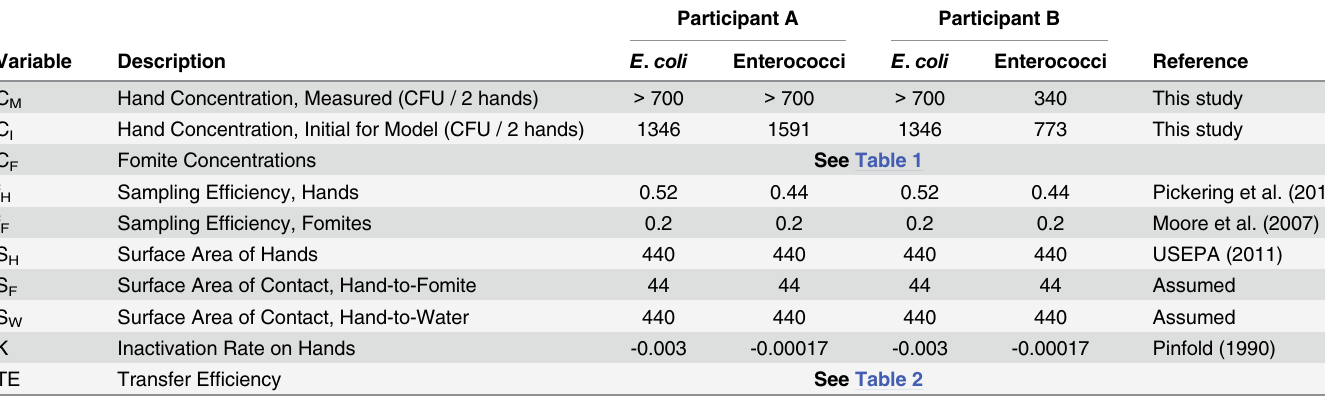
Table 3. Exposure Model Parameters, Values, and